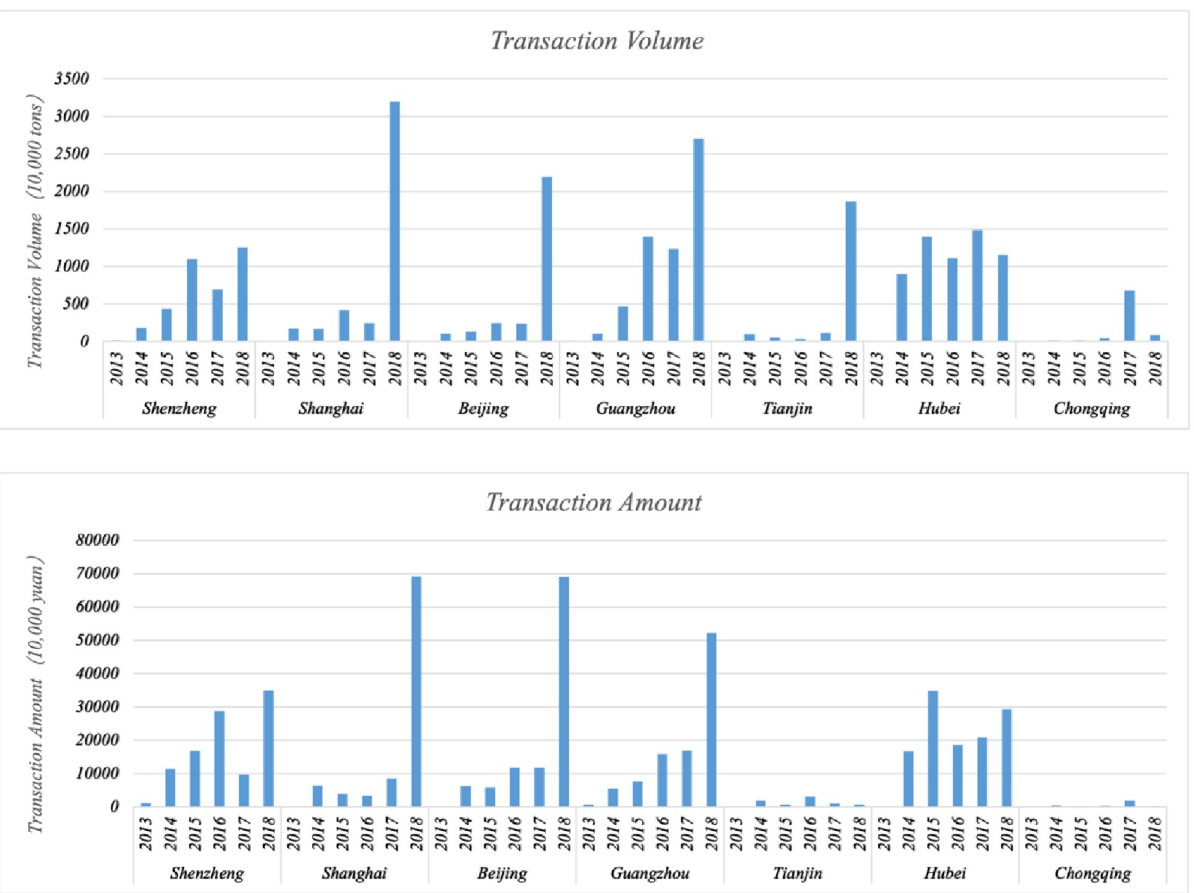
Fig 1. Transaction volume and transaction amount in China’s pilot carbon emission trading market from